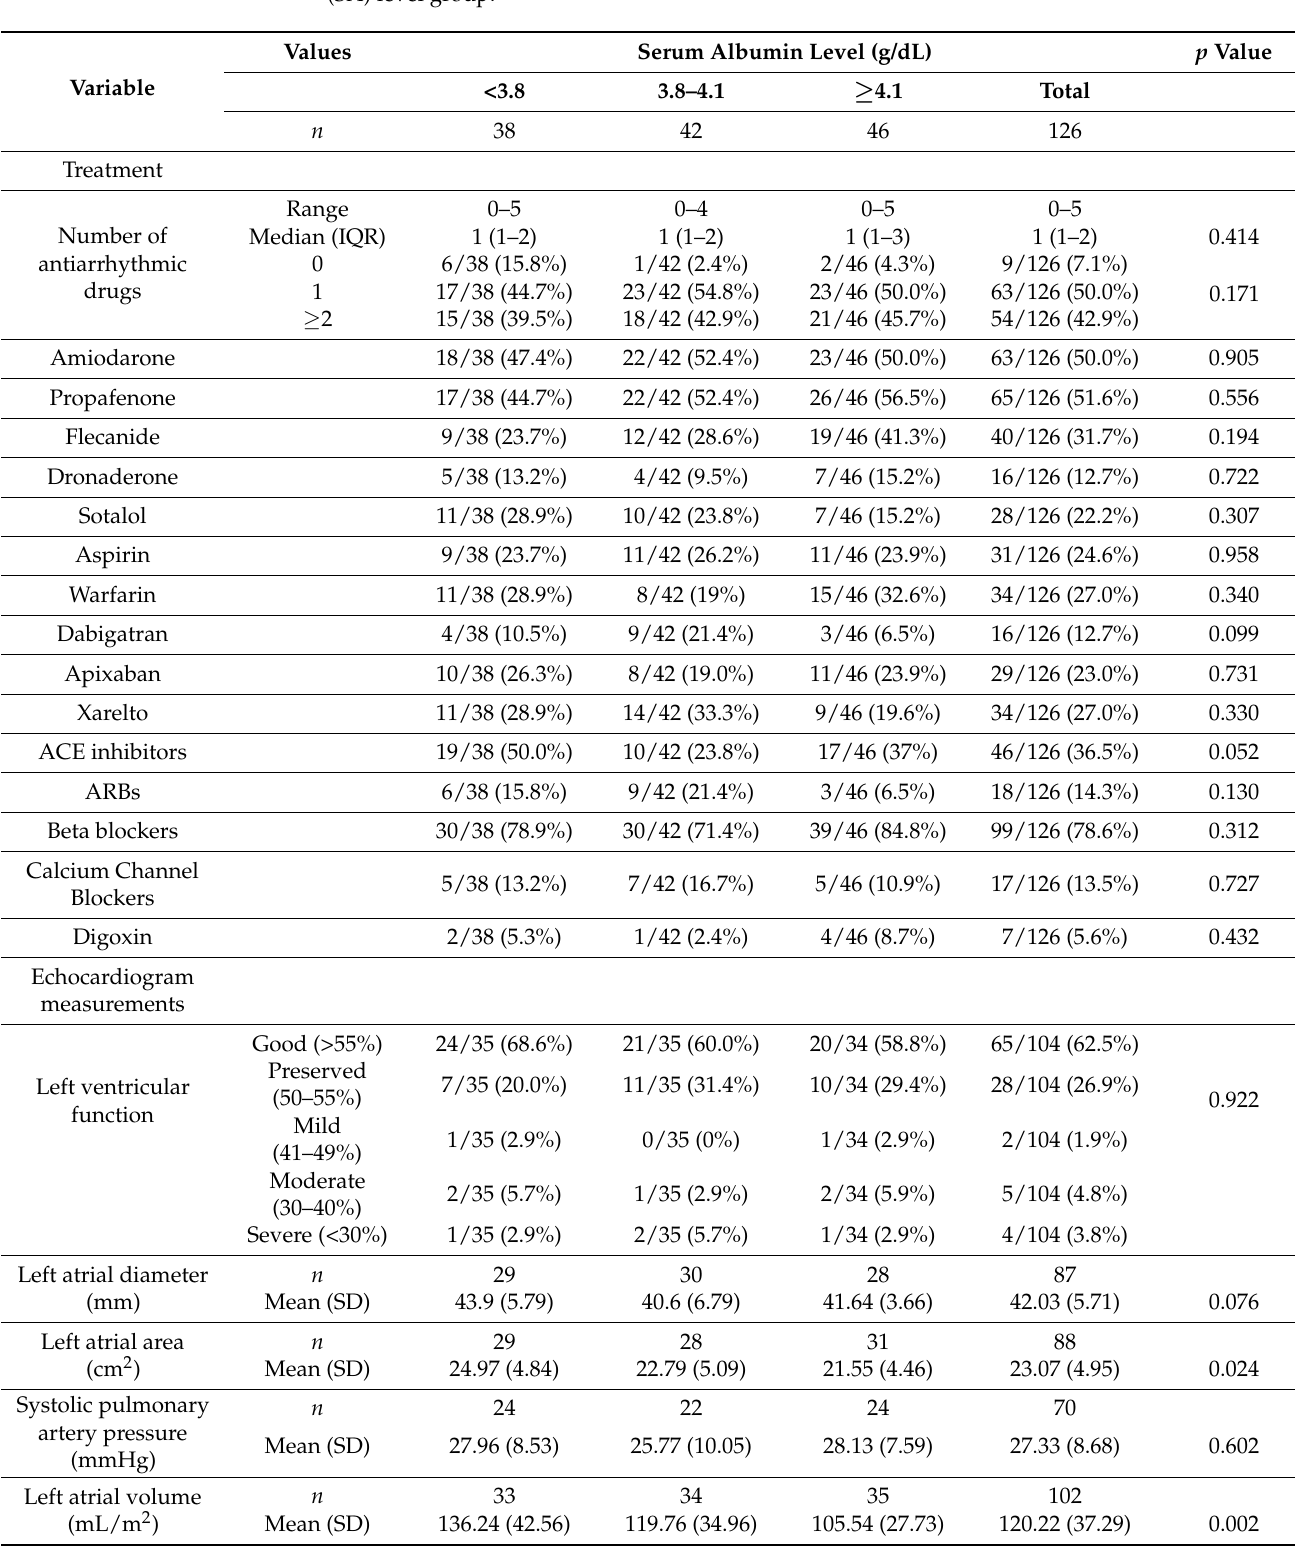
Table 3. Treatment and echocardiogram measurements (at the baseline) according to serum albumin (SA) level